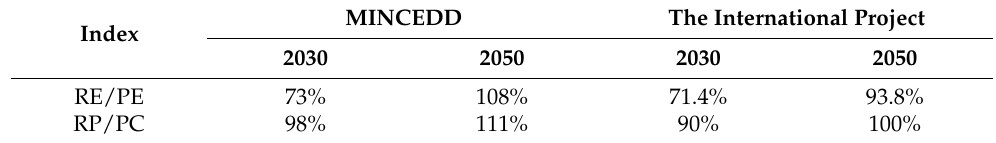
Table 19. Comparison of the MINCEDD indexes and the international